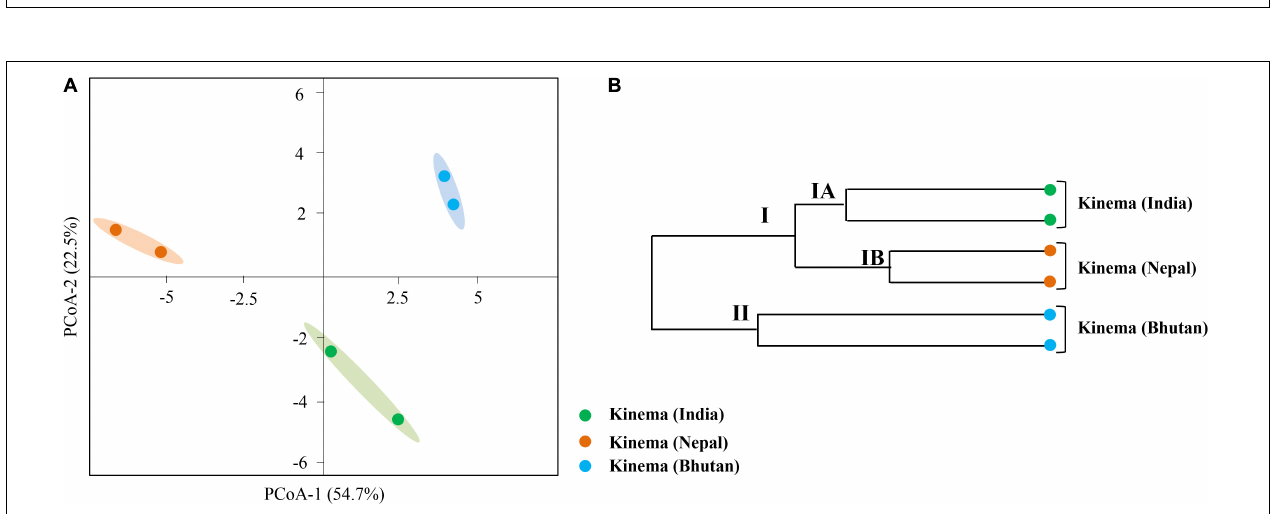
FIGURE 9 | Comparison of metabolite formation in kinema samples from India, Nepal, and Bhutan. (A) PCoA using Bray–Curtis dissimilarity. (B) UPGMA hierarchical clustering was plotted for the distribution of metabolites analyzed by liquid chromatography-mass spectrophotometry (LC-MS).